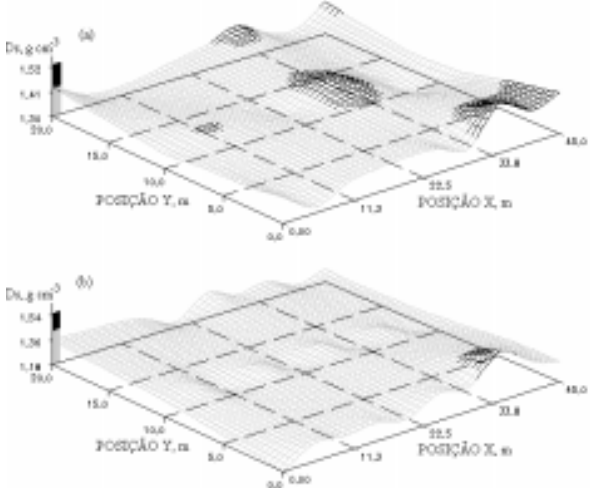
Figura 4. Superfícies de densidade do solo ( Ds ) para os piquetes em sistema de pastejo rotacionado: (a) resíduo de 2,0 a 2,5 t ha -1 MST (R1) e (b) resíduo de 3,0 a 3,5 t ha -1 MST